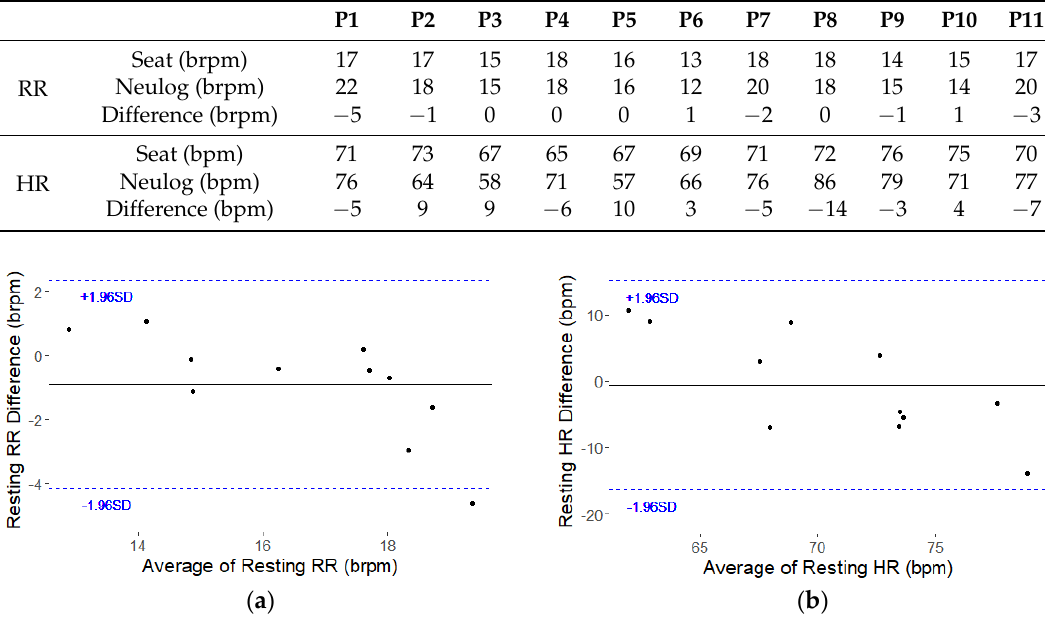
Table 3. Summary Statistics for the Peak Detection and Frequency Analysis Techniques for RR and HR using all Time Points across all Participants.